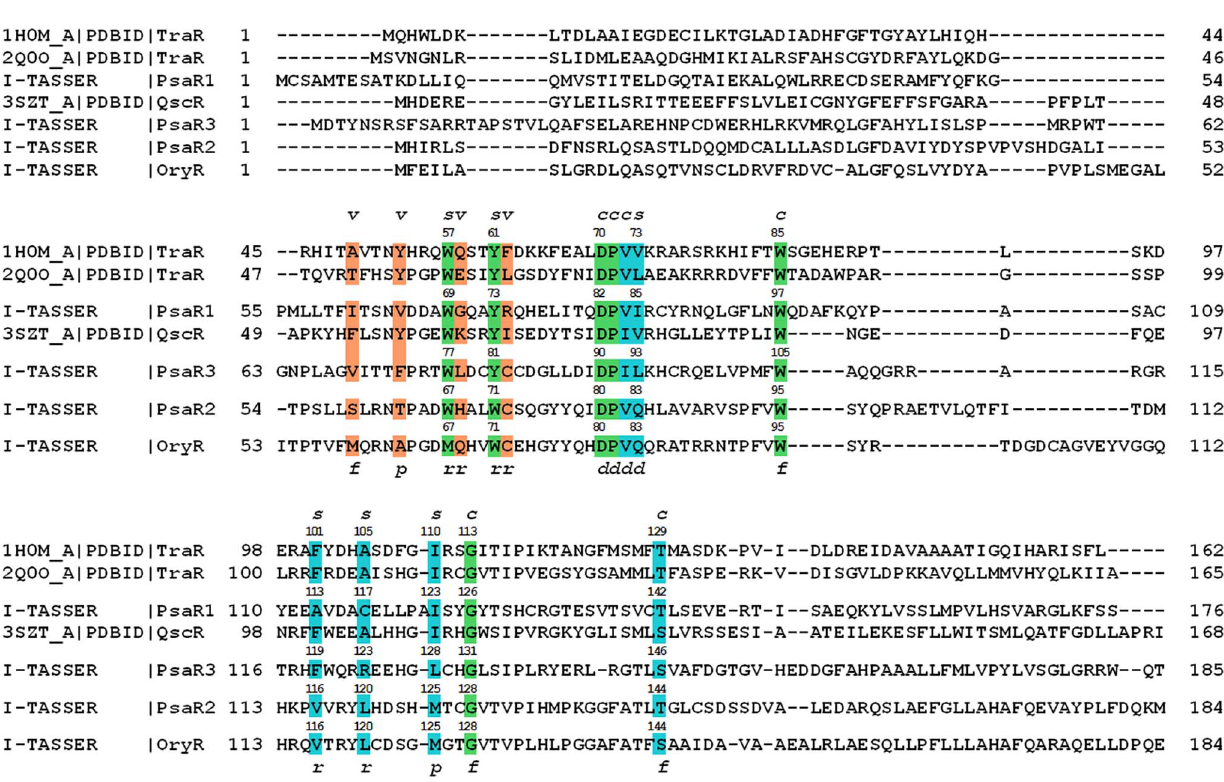
Figure 1. Structure-based multiple sequence alignment of the regulatory domains of the three Psa solos with QS LuxRs and with the prototype of the PAB LuxR solos subfamily. The residues belonging to Cluster 1, to Cluster 2 and Cluster 3 are highlighted in green, cyan and in orange, respectively. The 3D architecture of the boundaries of the ligand-binding site is schematized by r (roof), f (floor), p (proximal wall) and d (distal wall) and its tripartite topology by c (conserved core), s (specificity patch) and v (variable patch).